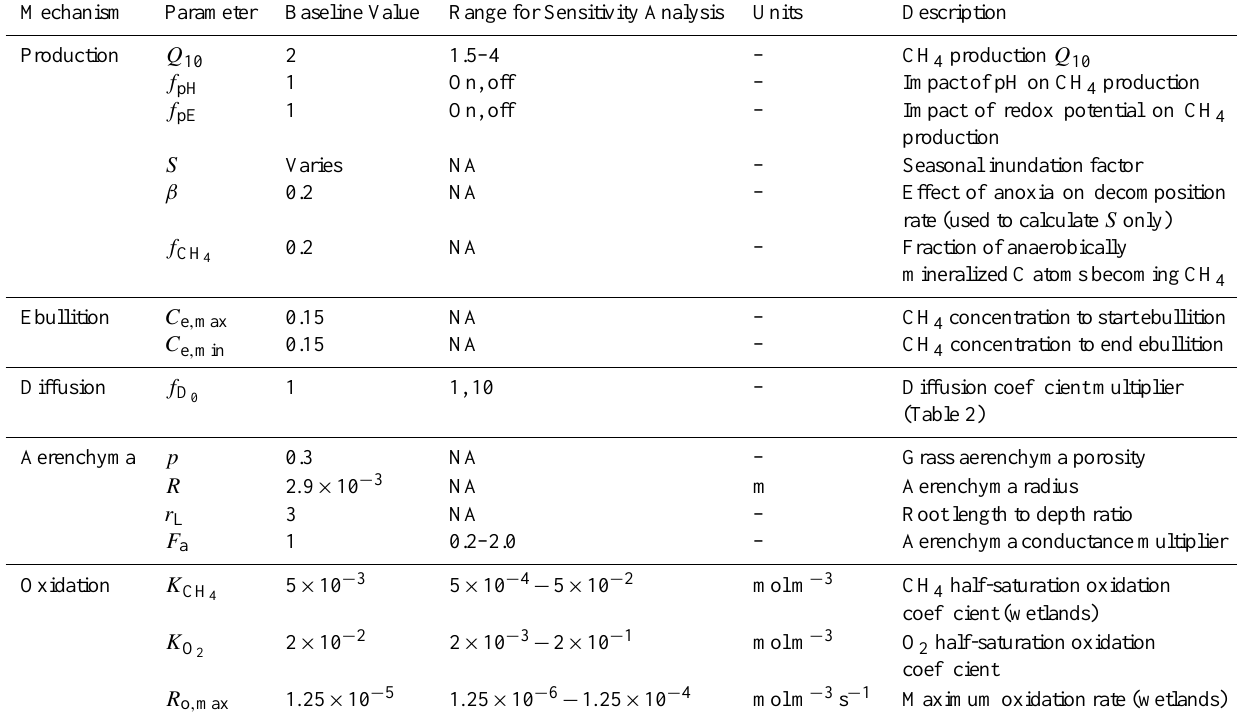
Table 1. Parameter descriptions and sensitivity analysis ranges applied in the